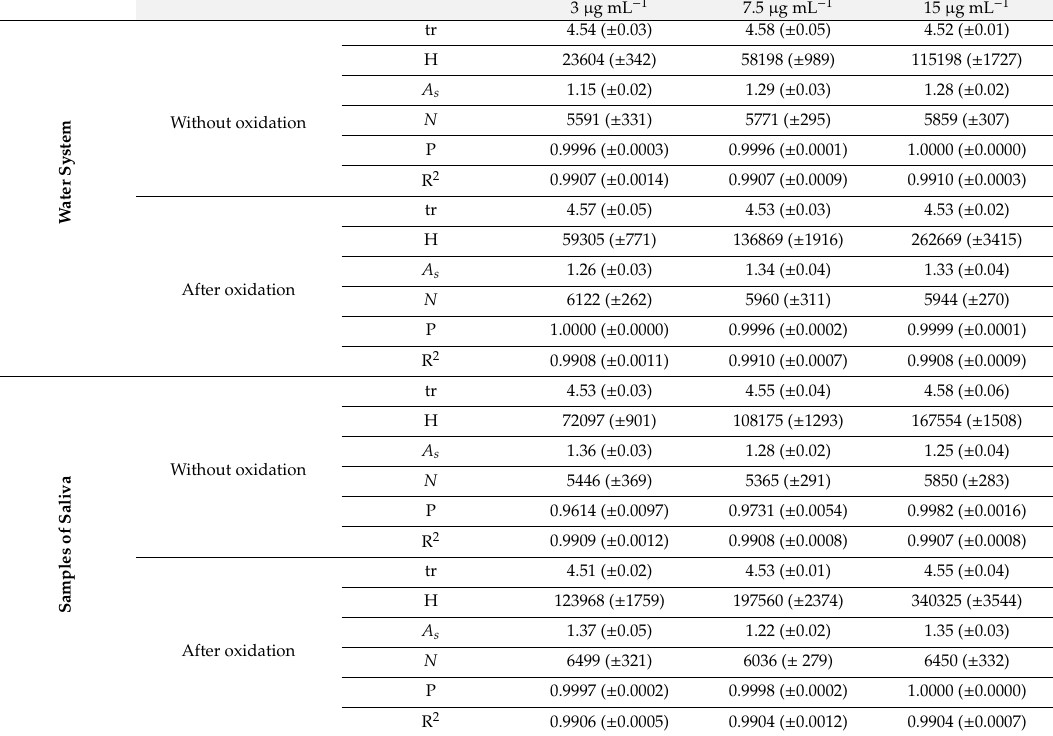
Table 3. Stability of the quantitation of nitrate in the water system and saliva samples ( n = 6).